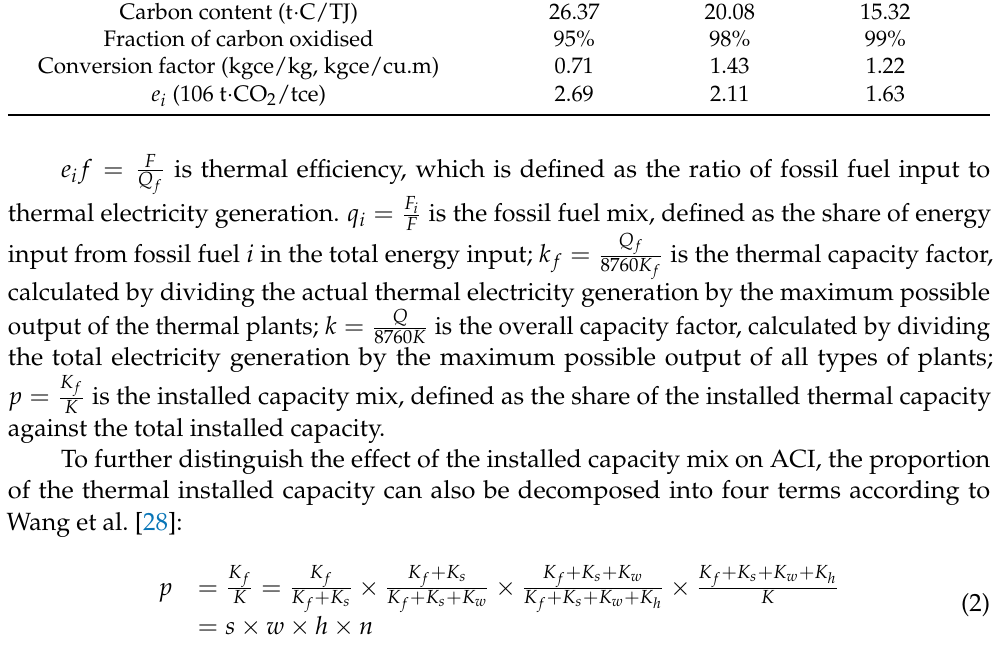
Table 1. Emission Coefficient Factor. Raw Coal Oil Natural Gas Average calorific value (kjoule/kg, kj/cu.m) 20,908 41,816 35,585 Carbon content (t · C/TJ) 26.37 20.08 15.32 Fraction of carbon oxidised 95% 98% 99% Conversion factor (kgce/kg, kgce/cu.m) 0.71 1.43 1.22 e i (106 t · CO 2 /tce) 2.69 2.11